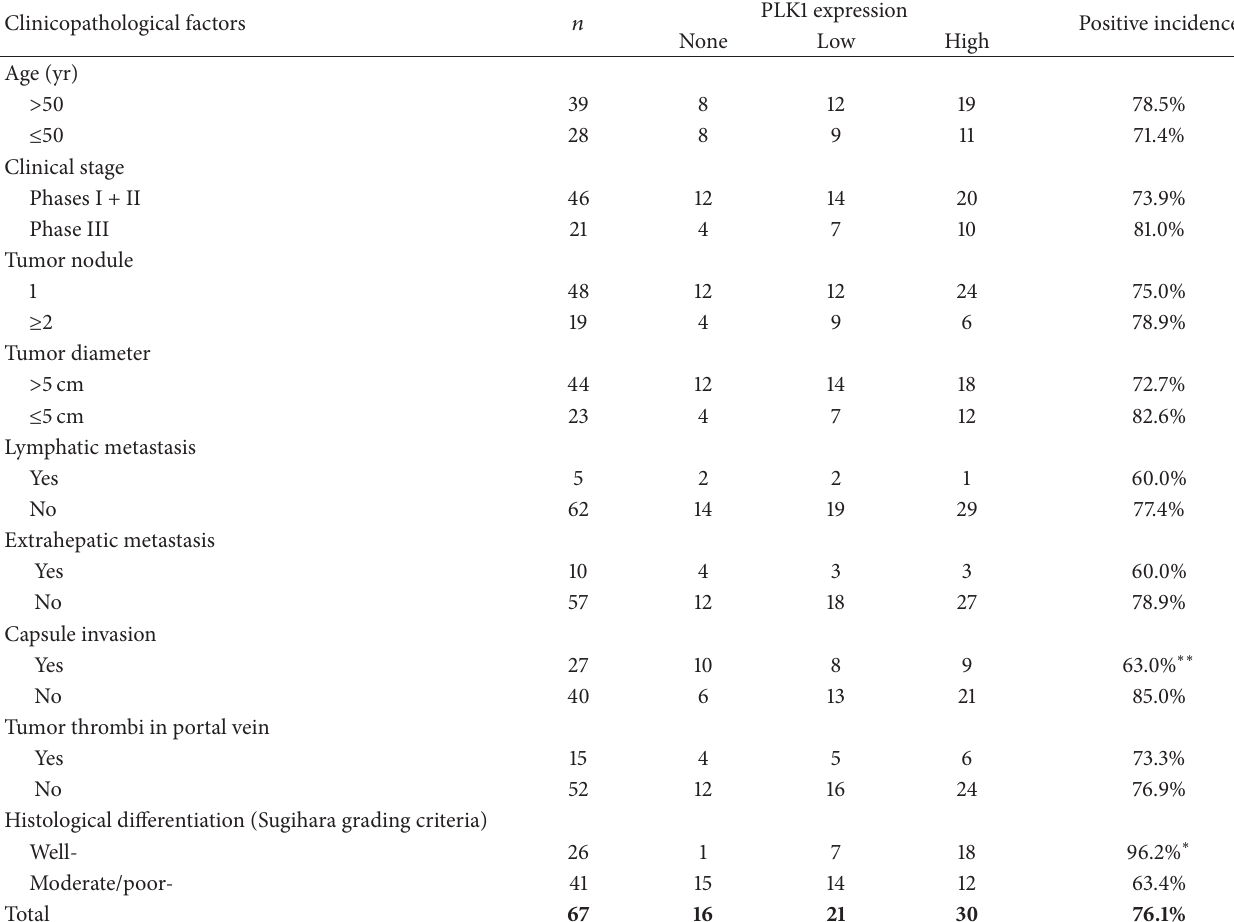
Table 1: The relationship of PLK1 expression and HCC clinicopathological